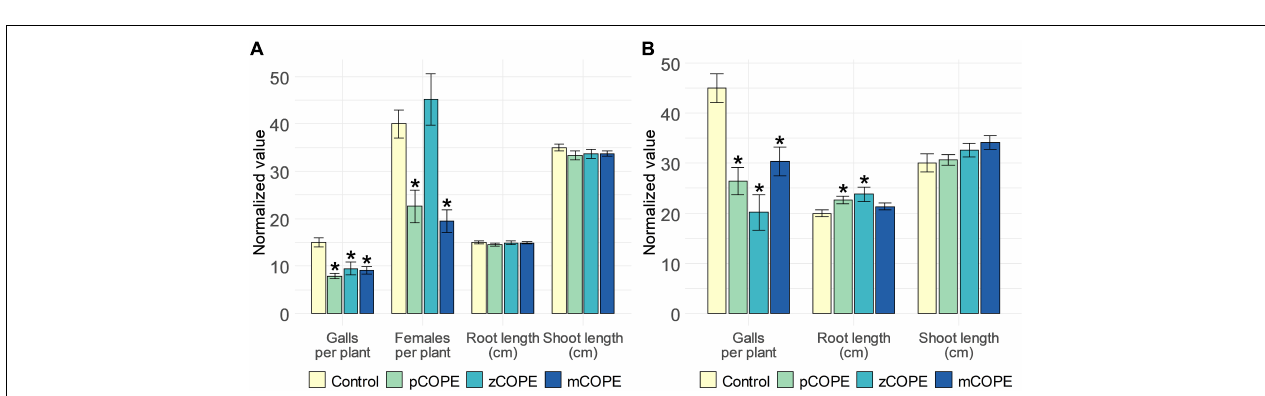
FIGURE 2 | Foliar application of Cucurbitaceae COld Peeling Extracts (CCOPEs) enhances the resistance of rice and tomato against the root-knot nematodes Meloidogyne graminicola ( Mg ) and Meloidogyne incognita ( Mi ), respectively. (A) Normalized infection and growth parameters, as assessed for rice plants 14 days post inoculation with 250 Mg second-stage juveniles (J2s). (B) Normalized infection and growth parameters, as assessed for tomato plants 28 days post inoculation with 250 Mi J2s. (A,B) One day before inoculation, shoots of 14-days-old plants were treated with the buffer used for CCOPE preparation (Control) or CCOPE derived from pumpkin ( Cucurbita moschata cv. Musquee de Provence; pCOPE), zucchini ( C. pepo var. cylindrica ; zCOPE) or melon ( Cucumis melo var. cantalupensis ; mCOPE). Error bars represent the standard error of the mean. Asterisks indicate statistically significant differences upon comparison of CCOPE- and mock-treated cells. Statistical differences were determined via a two-sided heteroscedastic t -test ( p < 0.05).